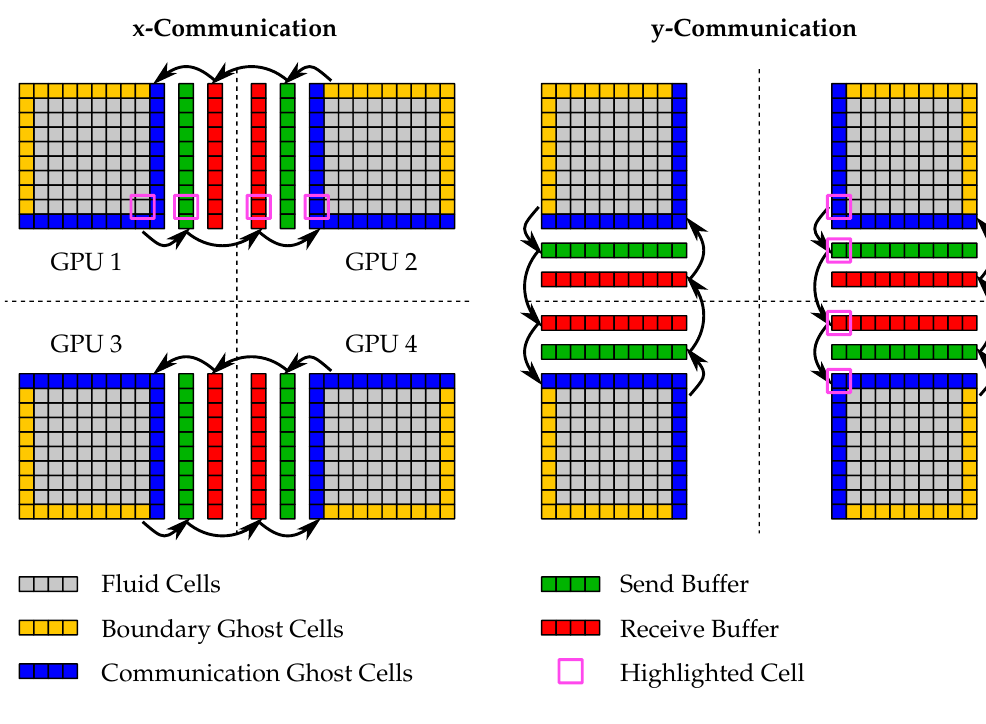
Figure 1. Multi-GPGPU communication pattern in two dimensions: The communication in the three directions is performed sequentially in the order x - y - z . The highlighted cell shows the information transport over diagonals.